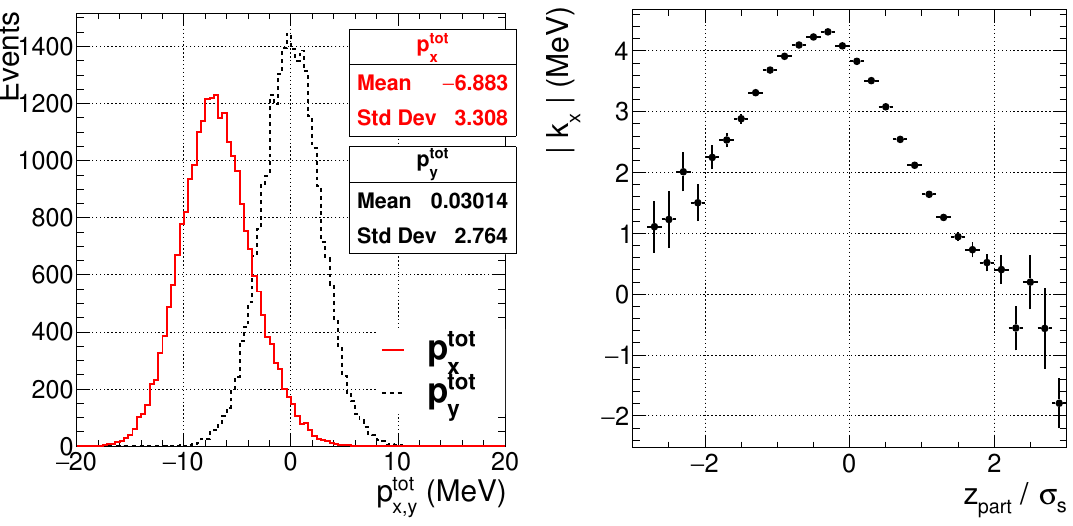
Figure 3 . Left: Distribution of the transverse components of the total momentum of e + e (cid:0) events, as predicted by Guinea-Pig . The direction of the x axis is chosen such that the bunches move with a negative velocity along x , and the p component is given in a frame that moves along (cid:0) x with x a velocity v = c (cid:2) sin (cid:11)= 2. Right: Kick along (cid:0) x that is acquired by an incoming e (cid:0) (or e + ) as a function of its longitudinal position z within the bunch, in units of the bunch length. Positive part (negative) values of z correspond to the head (tail) of the part